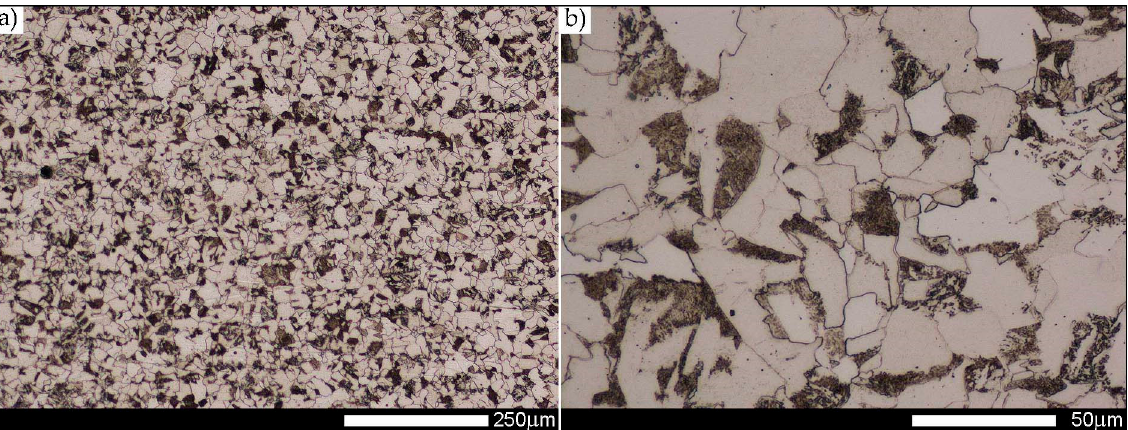
Figure 13. Microstructure of welded joint of Hardox 450 steel in the normalised state—BM zone shown in Figure 2b. ( a ) 100 × ; ( b ) 500 × . Relatively homogeneous ferritic–pearlitic structure with cementite precipitates at grain boundaries. Light microscopy, etched with 3% HNO 3 .